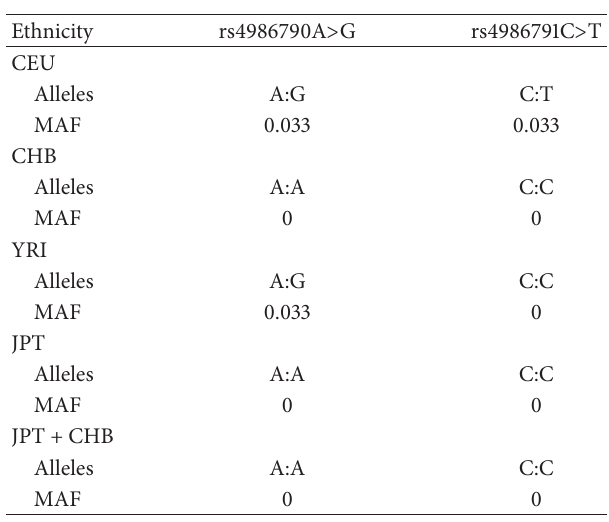
Table 1: MAF of the SNPs in different ethnic groups from the HapMap population.